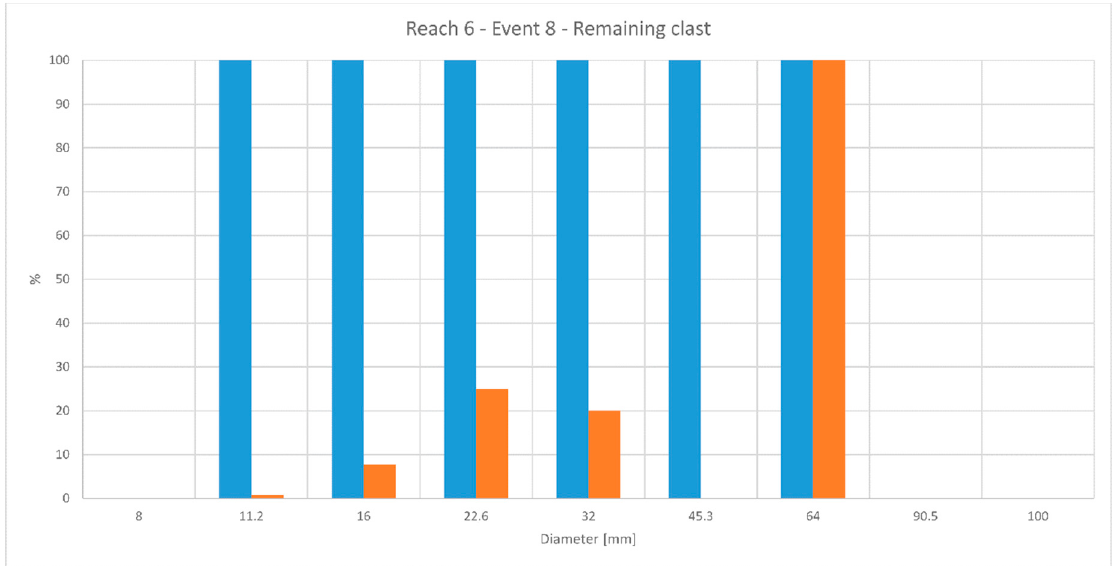
Figure 9. Remaining clasts, as a percentage of the original sample, divided per granulometric class after event eight. The blue bar is the proportion of clasts before event eight (100%), the orange bar is for the amount after (variable percentage).